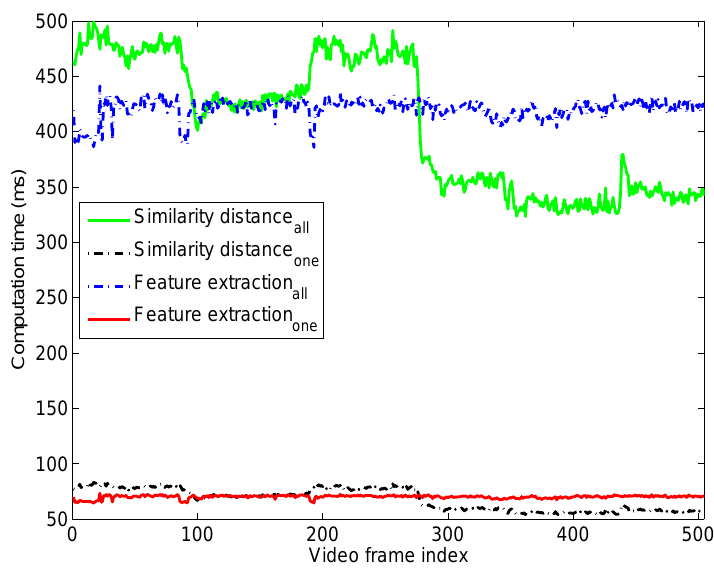
Figure 7. Computation time for recognizing the emotional states.